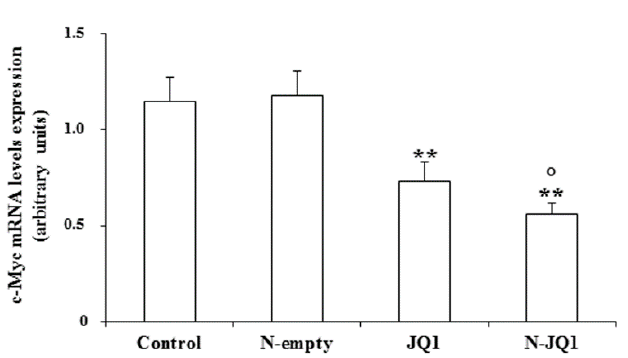
Figure 8. c-Myc mRNA levels in tumor tissues. Control, untreated mice JQ1; N-empty, unloaded nanoparticles; JQ1 (20 mg/kg) diluted in PBS + 5% PEG 400 + 5% TWEEN; N-JQ1, nanoparticles containing JQ1 20 mg/Kg. Values are expressed as means ± SD. * p < 0.05 vs. control, ** p < 0.01 vs. N-empty; ° p < 0.05 vs. JQ1.